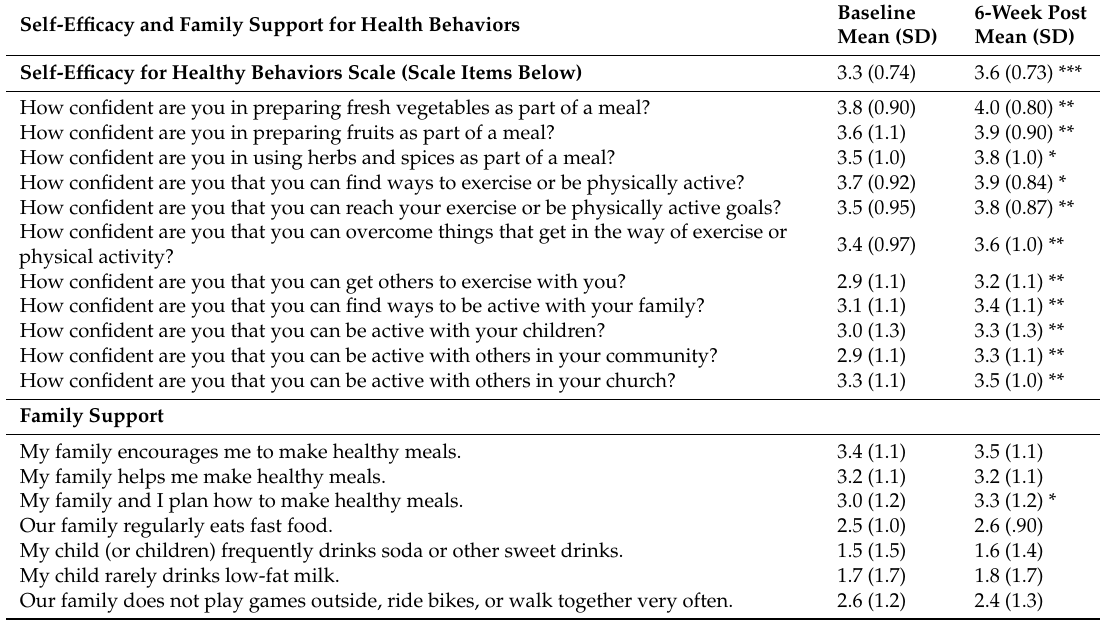
Table 5. Self Efficacy and Family Support Mean